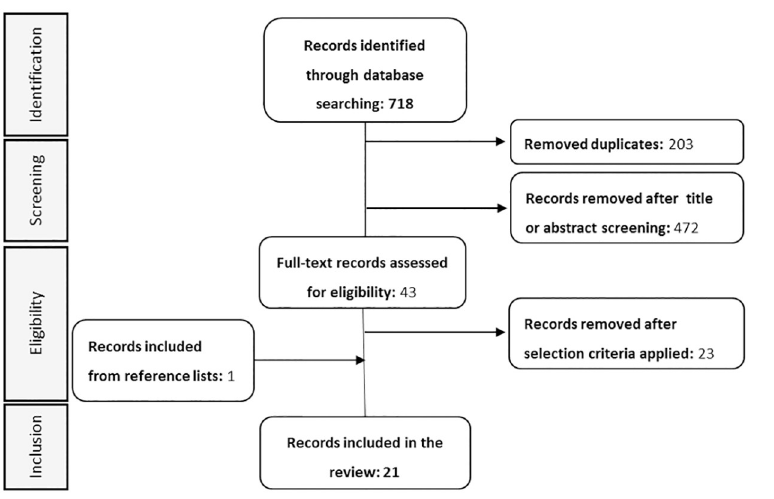
Fig 1. Study selection flowchart according to